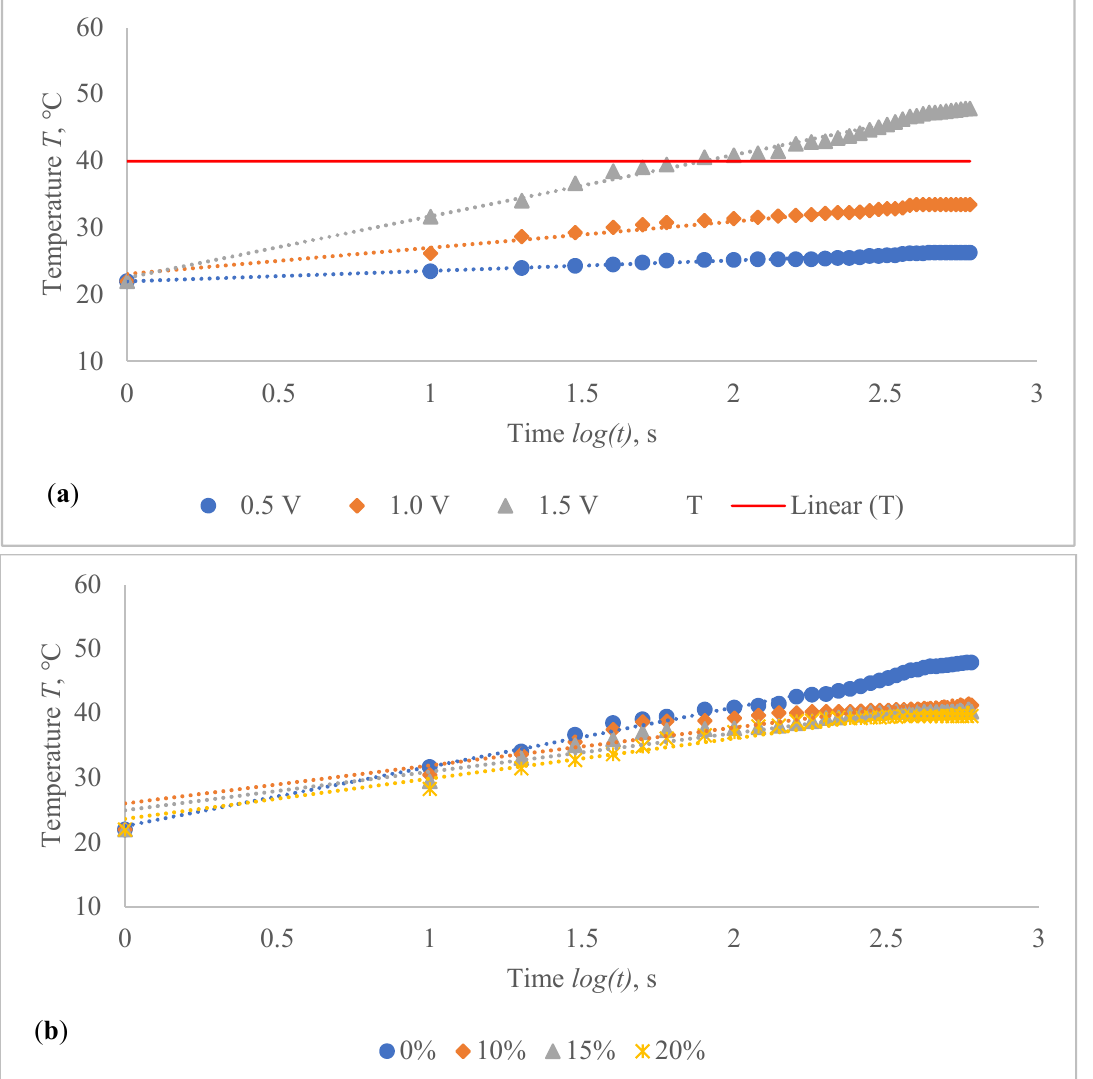
Figure 13. Temperature changes of CF_HY1 structured electro-conductive composite fabric during the 600 s period: ( a ) at non-stretched state by applying different voltage; and ( b ) at the different stretch levels by applying 1.5 V.